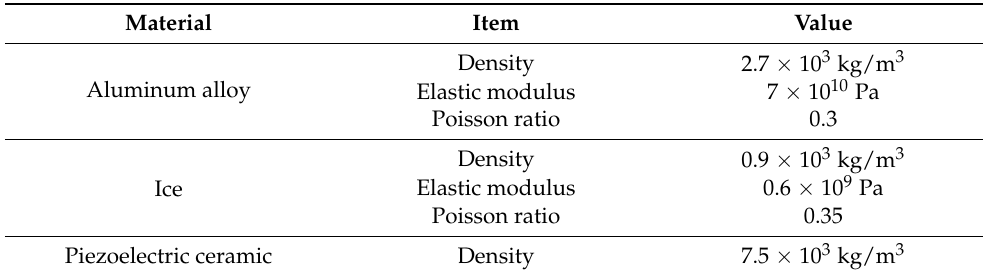
Table 1. Properties of materials.